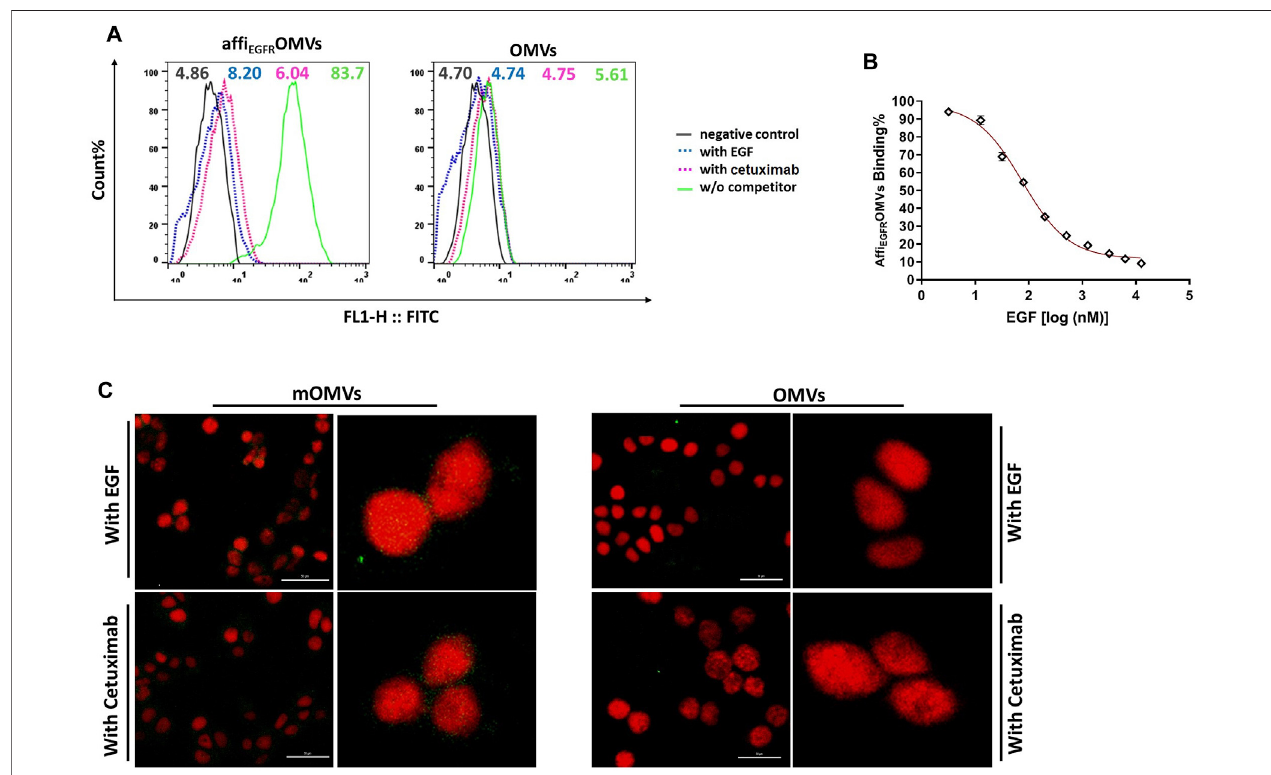
FIGURE 6 | Competition binding and delivery analyses. (A) MDA-MB-468 cells were pretreated with competitors (EGF or Cetuximab) and then treated with the af fi EGFR -OMVs. The fl ow cytometric results of cellular binding indicated that pretreatment of MDA-MB-468 with EGF or Cetuximab caused a signi fi cant shift in the fl uorescence. (B) Af fi fl ow cytometric results, EGFR -OMVs treated MDA-MB-4568 cells were co-incubated with the increasing amounts of EGF for 1 h. As declared by bindingoftheaf fi EGFR -OMVstotargetcellsgraduallydecreasedinthepresenceofincreasingamountsofEGF. (C) TheMDA-MB-468cellswerepretreatedwithan excess amount of the competitors. The uptake data from confocal microscopy demonstrated a signi fi cant reduction in green fl uorescence intensity of the modi fi ed OMVs-treated cells. Scale bar in un-zoomed pictures represents 50 μ m. Cells were stained with anti-af fi body antibody and FITC- conjugated rabbit anti-goat IgG.